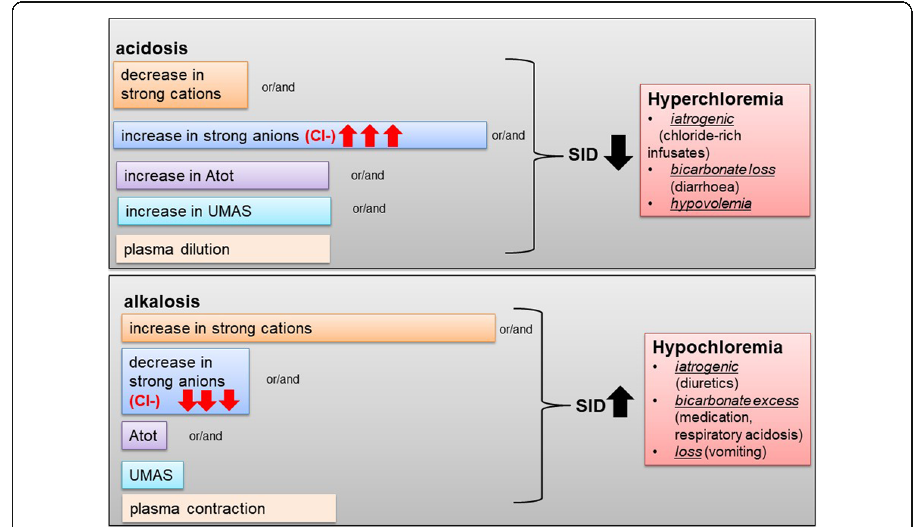
Fig. 3 Influence of chloride on acid-base